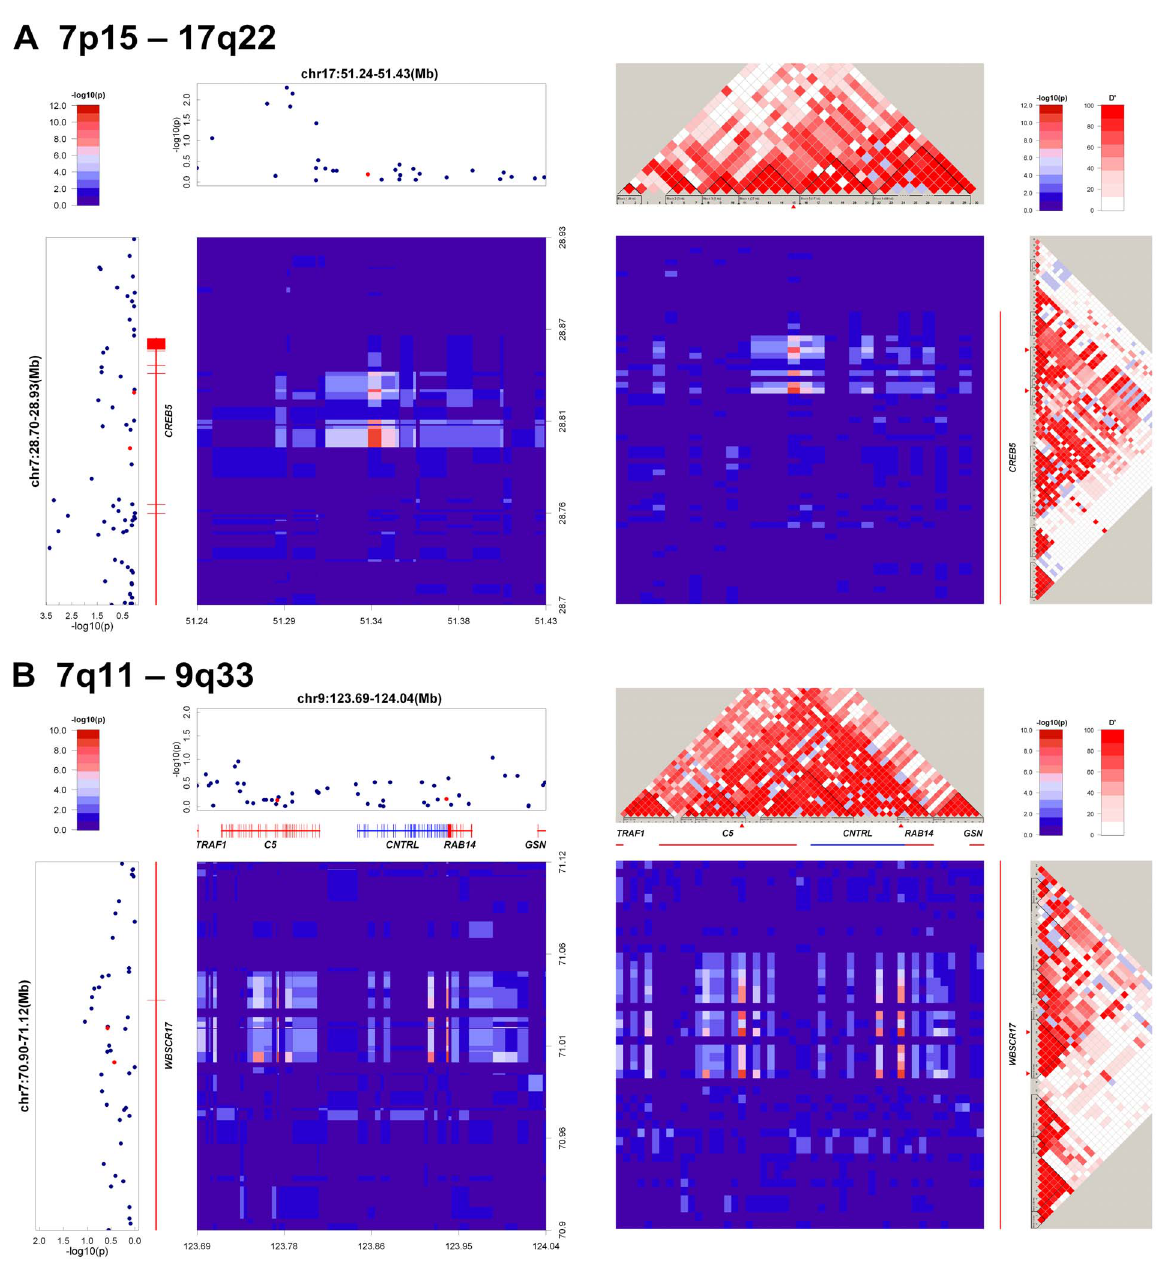
Figure 1. Regional signal plots of all SNPs within 100 kb of the top 2 interactive. SNP pairs identified. In each figure, the left panel shows the interaction signal heat-map and single-locus signal plots. The heat-map is aligned by chromosome positions based on NCBI build 36. Single-locus signal plots with gene annotations (lower left and upper-right) . In the single-locus signal plots, red is the position of suggestive-interacting SNP pairs in the corresponding regions. In the single-locus signal plots, solid black dots denote logistic regression test P values. In the interaction-signal heatmap plot, interaction P values, transformed by a negative logarithm, are coded by color (key in upper-left box) . Interaction signal heatmap and LD plot (right panel) . Heatmap is aligned with each SNP equidistant from LD plot positions. Interaction-signal heatmap and LD plots are color coded (key upper right) . Single-locus signal plots (lower left) same as above, except that coordination is not based on chromosome position. In detailed LD structures estimated in control samples (upper left and lower right) increasing intensities of red represent higher D’ values, and solid red triangles denote the positions of potentially interacting pairs of SNPs. Genes annotated in this region are also depicted according to their relative positions on the LD plot. On the heatmap, yellow dot is position of suggestive interacting pairs of SNPs in their corresponding regions.